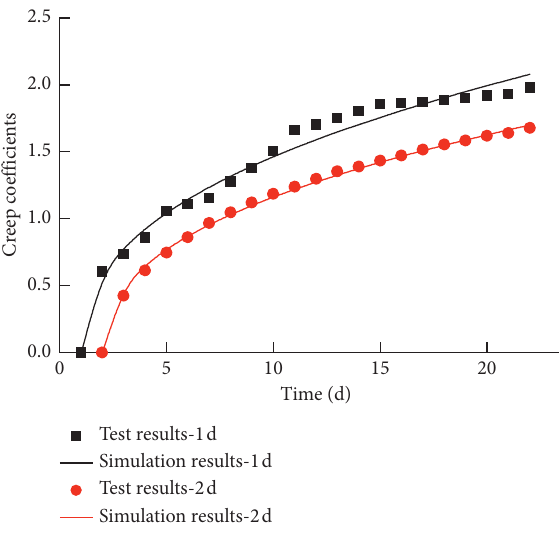
Figure 11: Creep